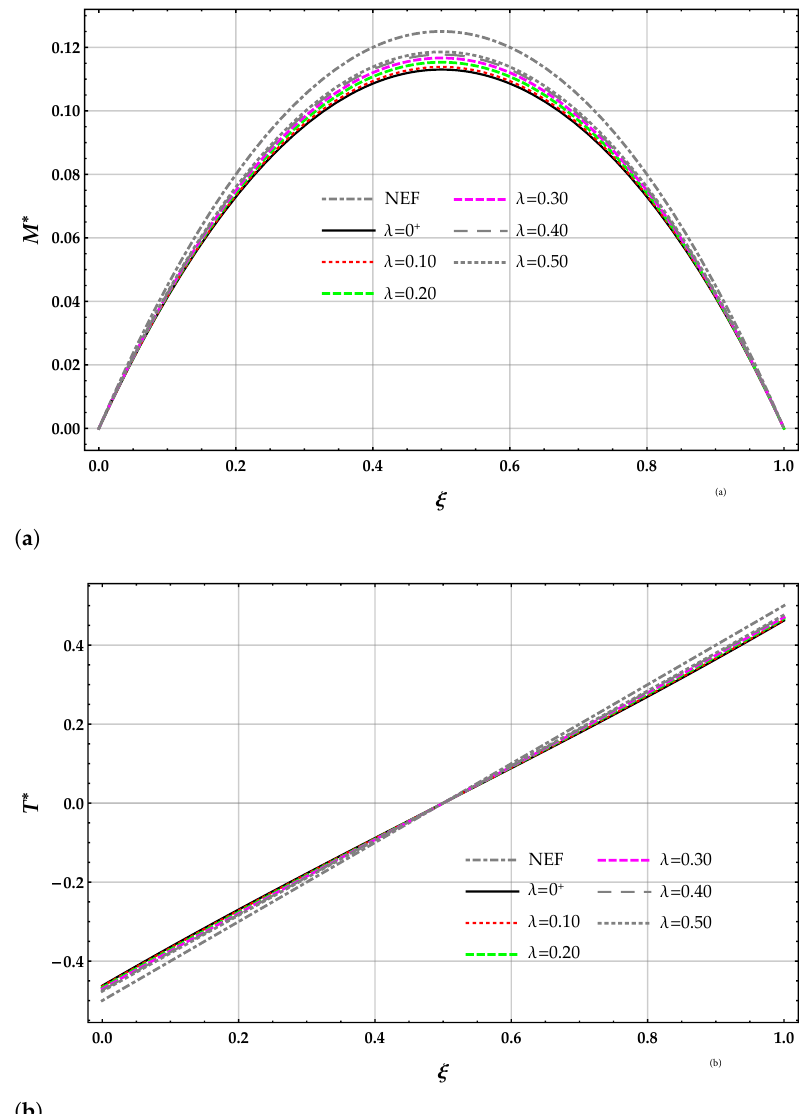
Figure 8. SS − q beam. Plots for increasing values of the non-dimensional non-local parameter λ in (cid:8) (cid:9) the set 0 + ,0.1,0.2,0.3,0.4,0.5 with k ∗ = 10 of ( a ) non-dimensional bending moment M ∗ using the DD method and ( b ) non-dimensional shear force T ∗ using the DD method. A comparison of the midpoint non-dimensional displacement v ∗ ( 1/2 ) , reaction r ∗ ( 1/2 ) , bending moment M ∗ ( 1/2 ) , and shear force T ( 1 ) of the DD and MRD meth- ods are plotted in Figure 9a–d. Numerical outcomes of non-dimensional shear force T ( 1 ) of DD and MRD methods are given in Table 9 while numerical results of non-dimensional = A ∗ parameters A ∗ obtained by the MRD method are provided in Table 2 1